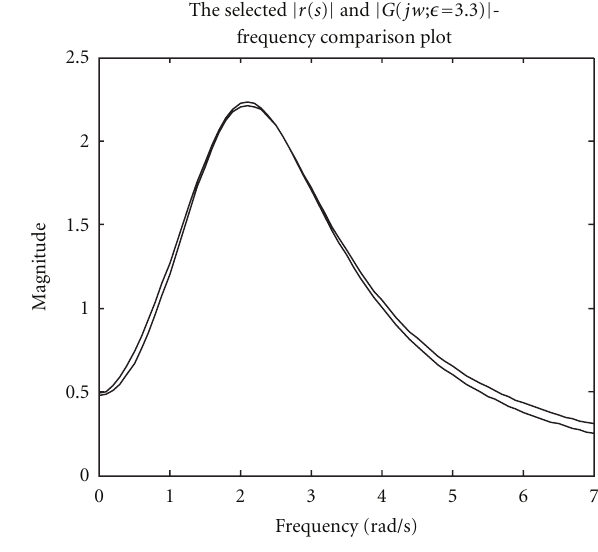
Figure 6: Additive uncertainty case with ε 1 = 3 . 3.